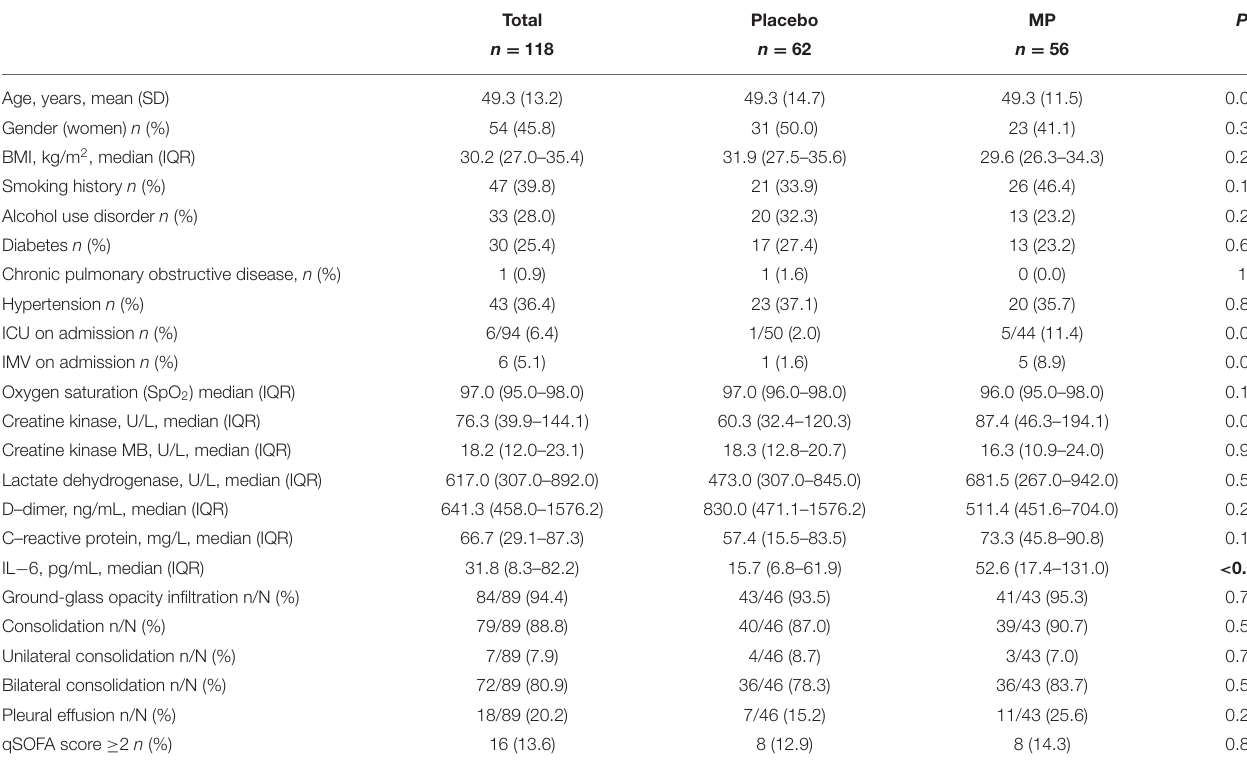
TABLE 1 | Baseline (D1) demographic, clinical, laboratory, and radiological findings of survivors of COVID-19 which returned on follow-up visit 120 days, and major therapeutical interventions from D1 to D120.